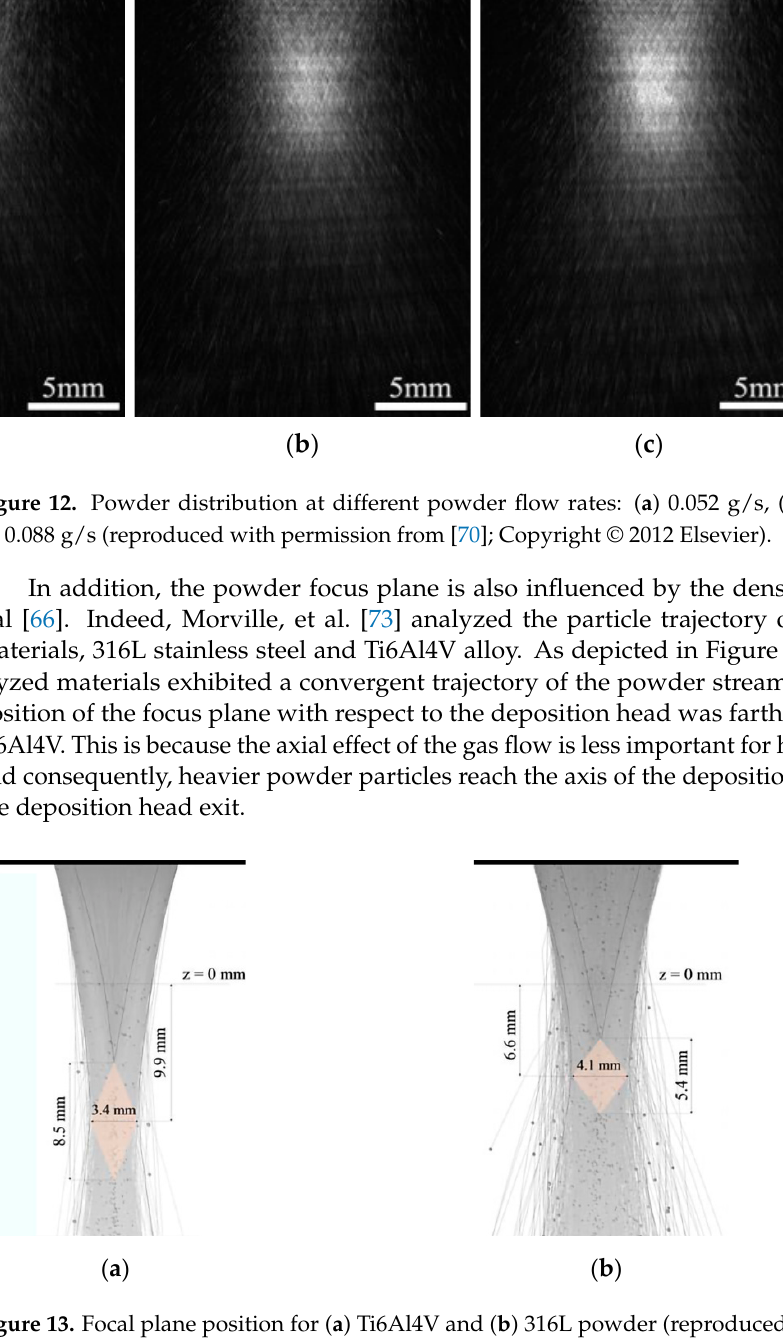
Figure 11. Variation of particle concentration with ( a ) inner shielding gas velocity and ( b ) powder flow rate [71].